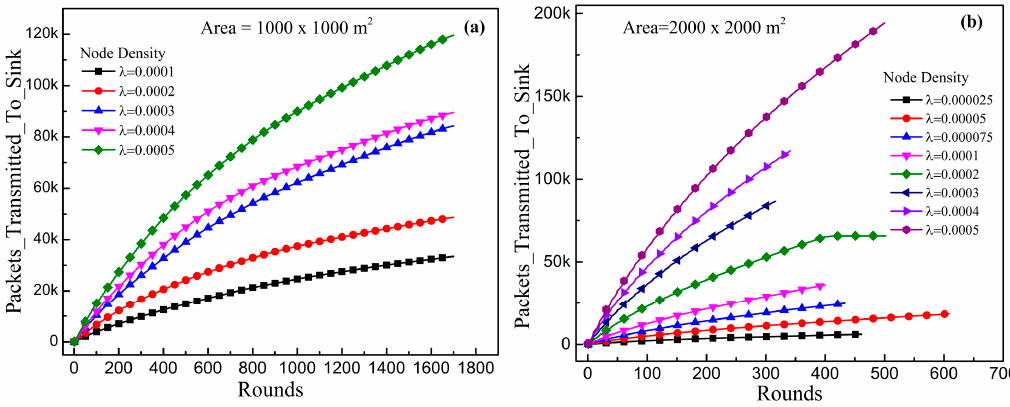
Figure 12. Total packets sent towards the sink in ( a ) 1000 m × 1000 m, and ( b ) 2000 m × 2000 m area.